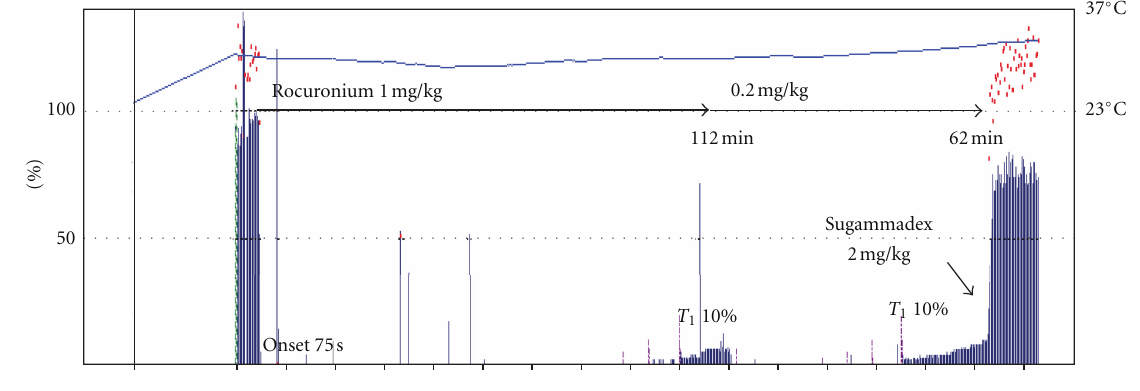
Figure 1: A serial recording of acceleromyography in a patient with myotonic dystrophy. Blue longitudinal bars show T1 height in the train- of-four responses, and red dots mean the train-of-four ratios. Marked prolongation in durations of rocuronium-induced neuromuscular block and rapid recovery from neuromuscular block after sugammadex administration are